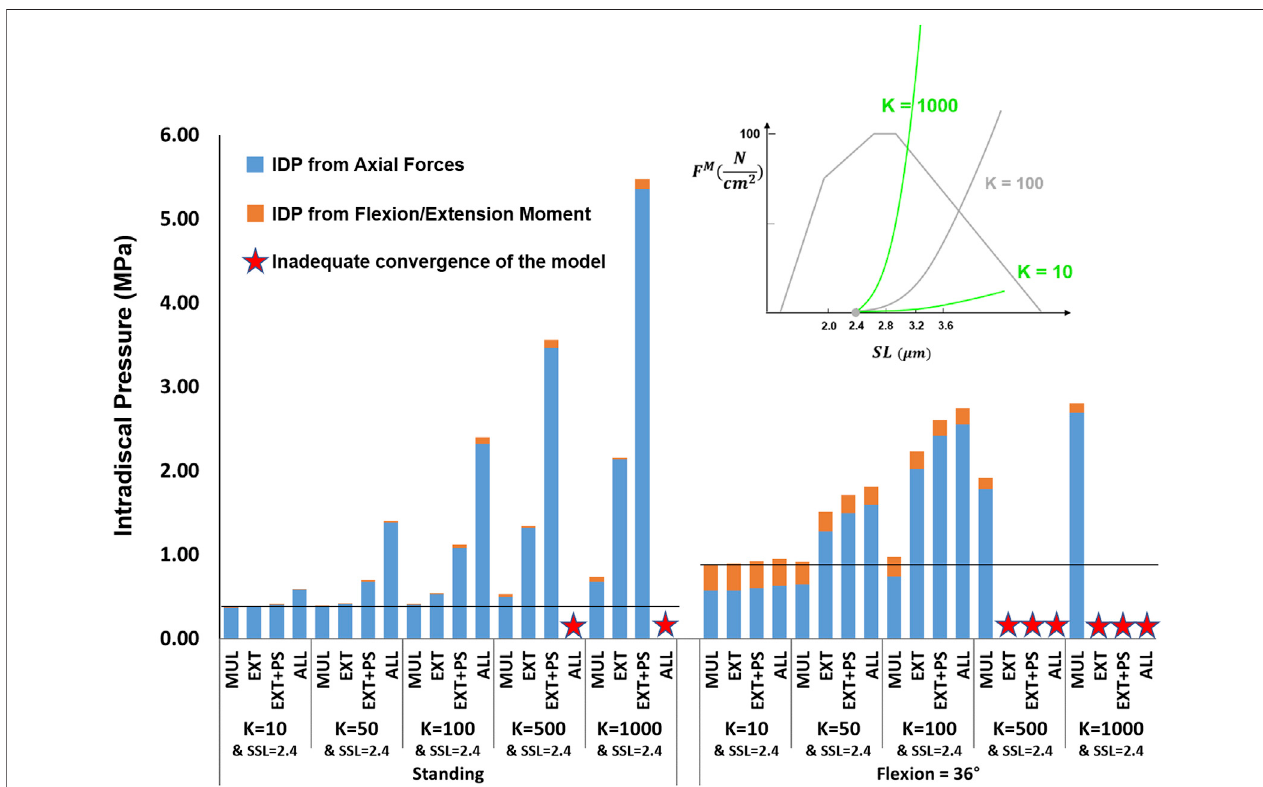
FIGURE 7 | The effect of different passive force-length curve scaling constants (K in N ) combined with a slack sarcomere length (SSL) of 2.4 μ m to the targeted cm 2 muscles on L4-L5 IDP in upright standing and 36 ° fl exion for four scenarios: changes applied to multi fi dus (MUL), extensor muscles (EXT), extensor muscles and psoas (EXT + PS), and all 210 muscles in the model (ALL). The black horizontal lines represent the baseline